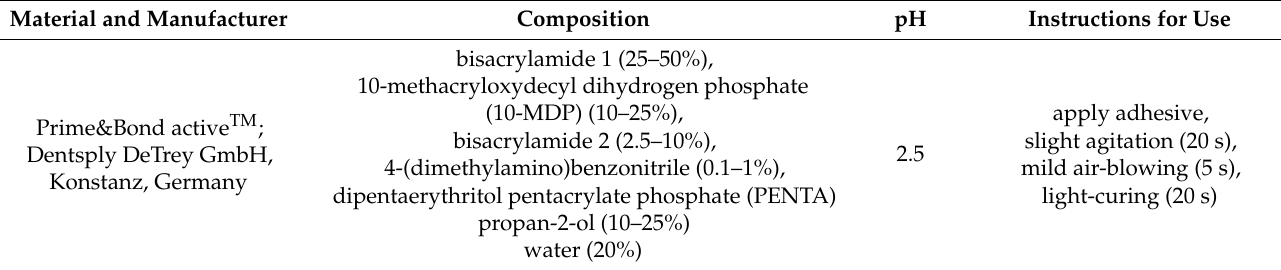
Table 1. Chemical composition of universal adhesive and instruction for material used. Material and Manufacturer Composition pH Instructions for